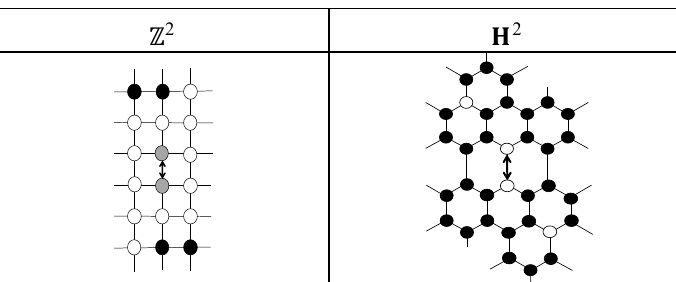
Figure 3. Repeatable configurations of